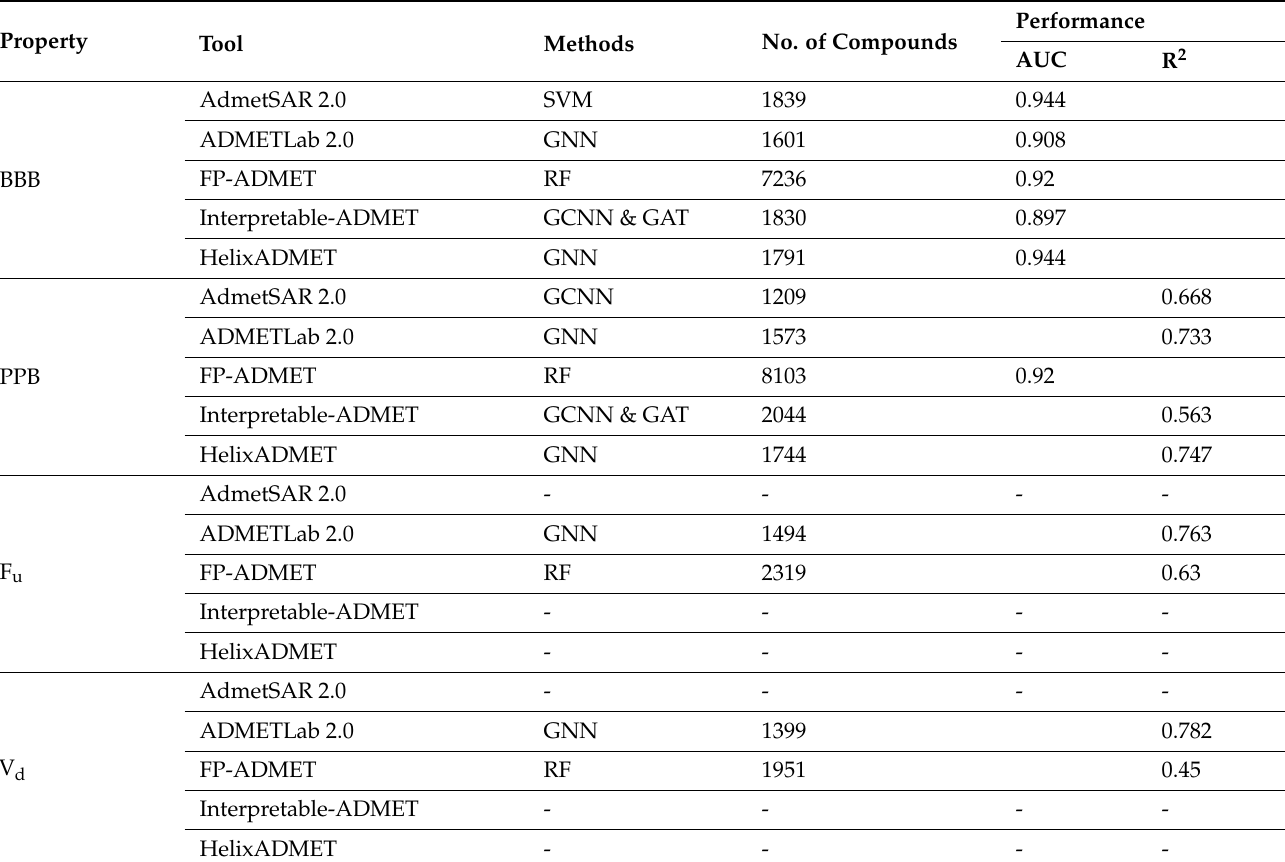
Table 6. Performance of five ADMET prediction tools on distribution property